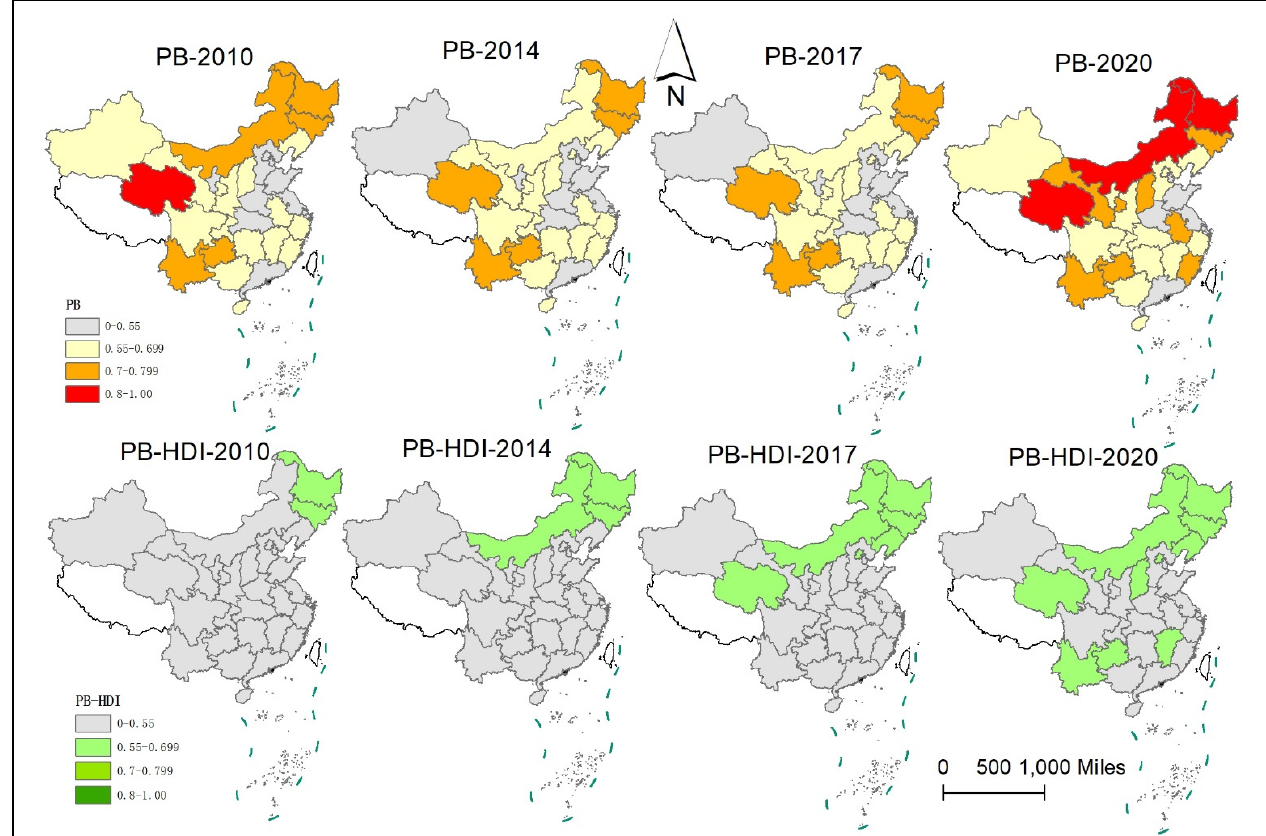
Figure 3. Spatial distribution pattern of PB and PB-HDI for